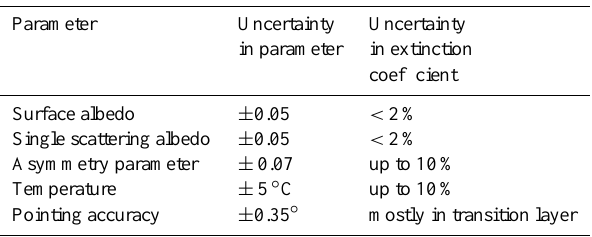
Table 5. Uncertainty in aerosol extinction coefficient due to uncer- tainty in model input